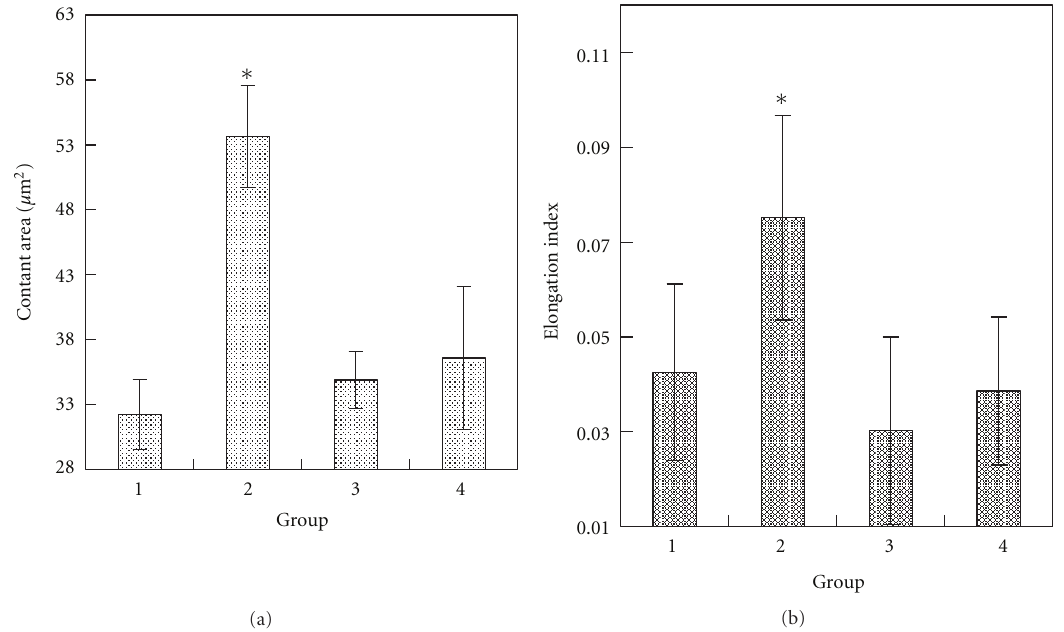
Figure 6: E ff ects of laser irradiation at 5mW for 5min on erythrocyte section area (a) and elongation index (b) with and without 0.2 µ mol/L HgCl 2 : (1) dehydrated erythrocytes in the hypertonic solution, (2) the dehydrated erythrocytes were irradiated with laser irradiation at 5mW for 5min, (3) the dehydrated erythrocytes were treated with HgCl 2 , and (4) the dehydrated erythrocytes were treated with HgCl 2 , then irradiated with laser irradiation at 5 mW for 5min. Data are means ± SD. N = 100. ∗ P < 0 . 05 versus group 1 as